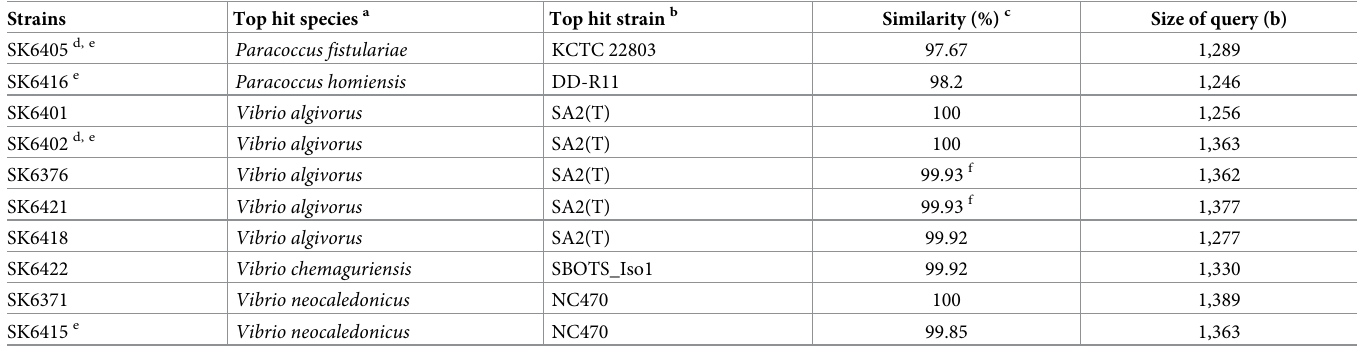
Table 3. Alginate-assimilating